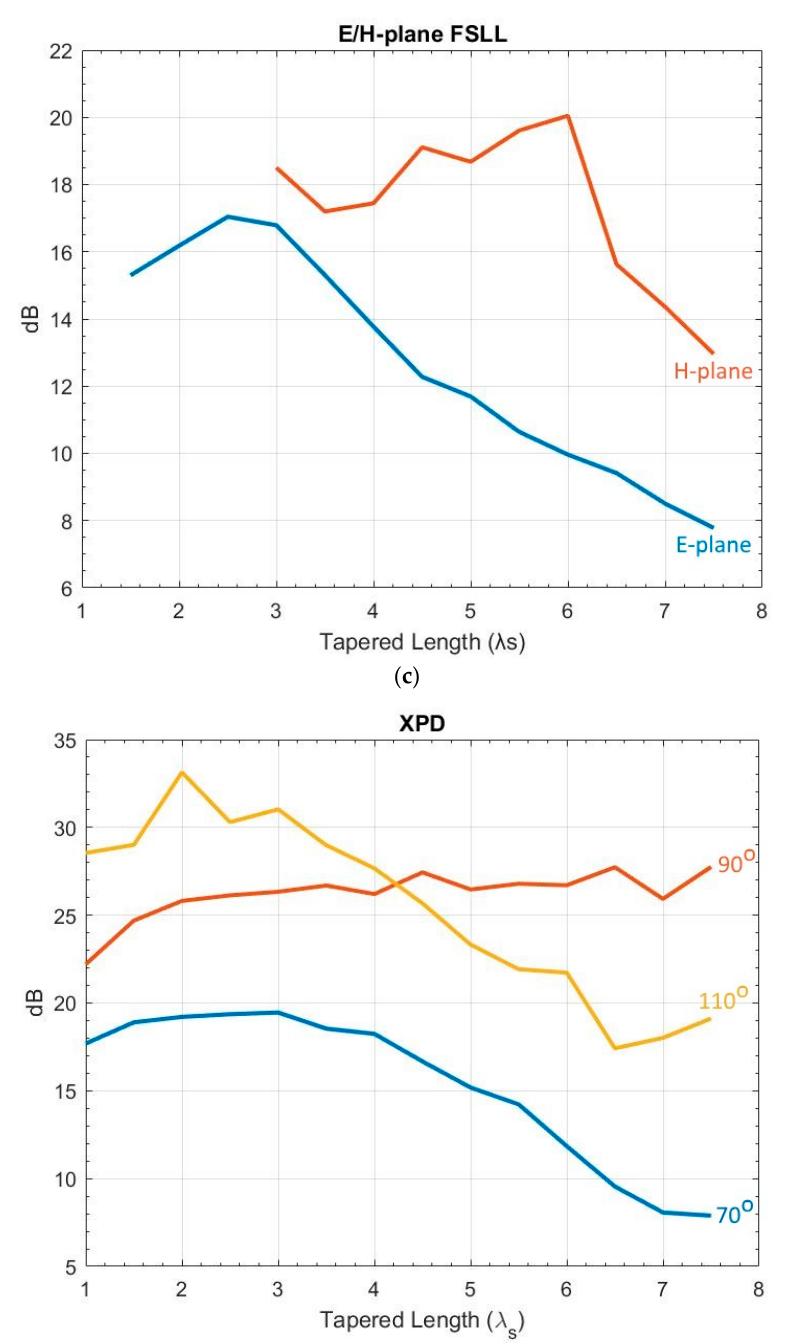
Figure 6. Variation of tapered length: ( a ) peak S11 of low, mid, high, and ultra bands (blue: low, red: mid, yellow: high, purple: ultra); ( b ) E/H-plane HPBW (blue: E-plane, red: H-plane); ( c ) E/H plane FSLL (blue: E-plane, red: H-plane); and ( d ) XPD (blue: 70°, red: 90°, yellow: 110°). Note: Missing data on H-plane FSLL resulted from no detectable front side lobe peak.